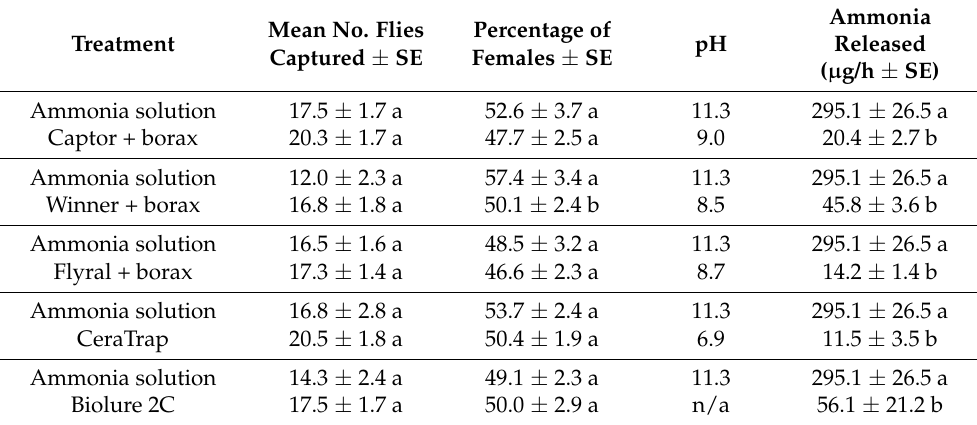
Table 1. Pairwise comparisons of mean ( ± SE) captures of A. obliqua flies, percentage of females captured, and quantity of ammonia released from individual traps baited with the 150 mM ammonia solution and different commercial attractants.